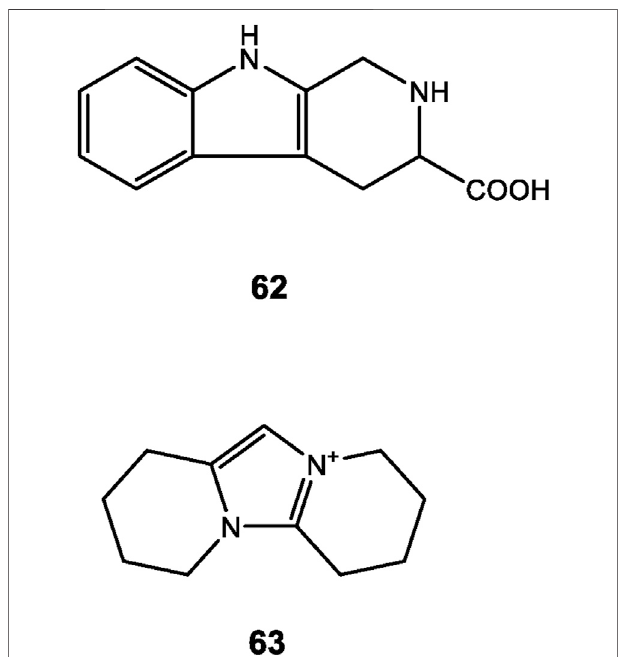
FIGURE 5 | Structures of indole and other alkaloids reported in Dendrobium .